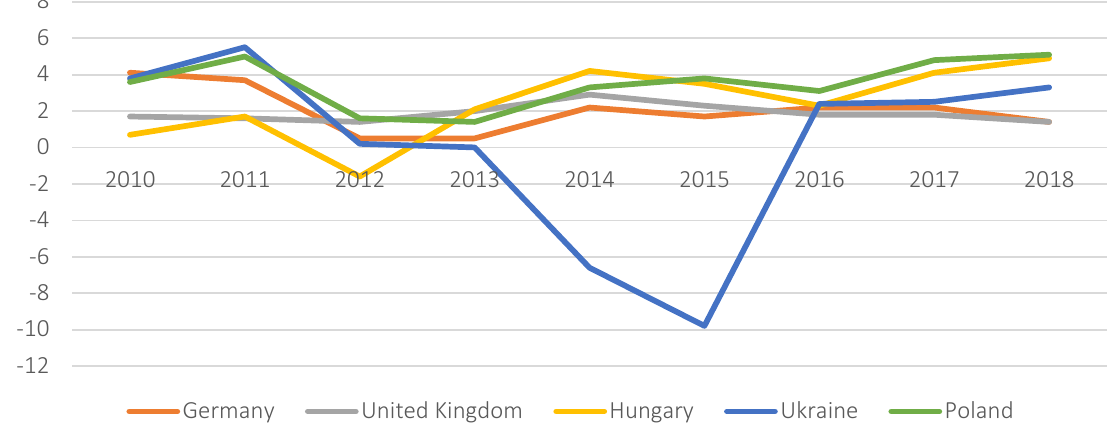
Figure 1. GDP growth rates in Ukraine and the EU countries,